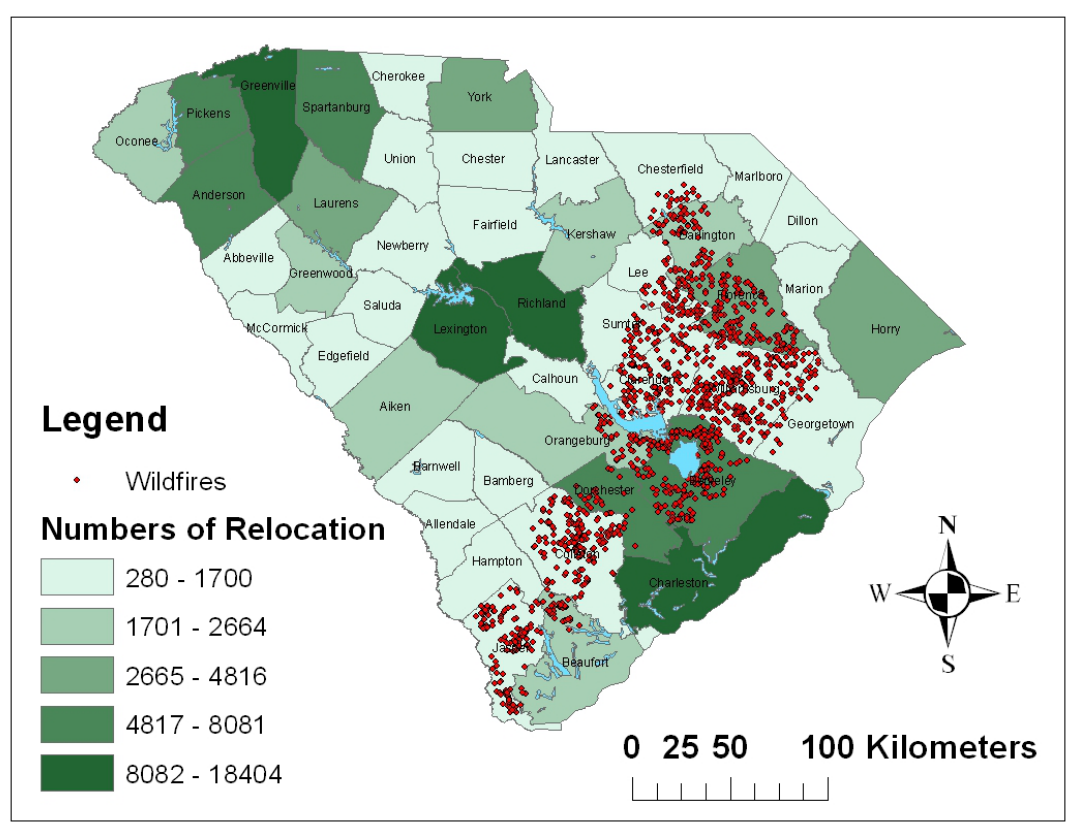
Figure 11. Population by county of geographic mobility (those who moved from a different county within South